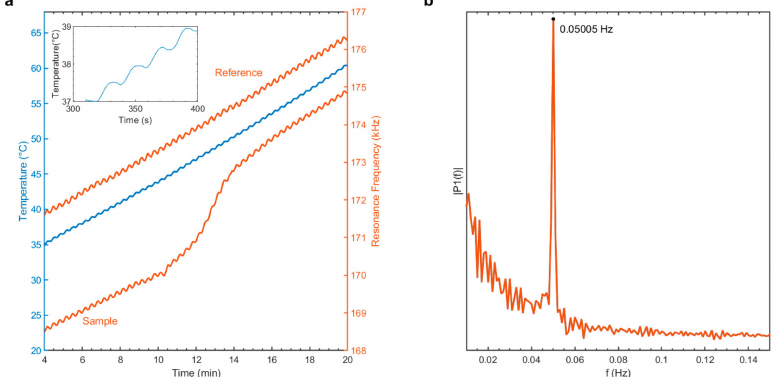
Figure 3. ( a ) Resonance frequency response of the reference (top) and sample (bottom) to the applied heating (middle). The inset shows a zoomed-in section of the heating profile, ( b ) Fast Fourier Transform of the measurement (sample signal of a) after detrend and normalization.